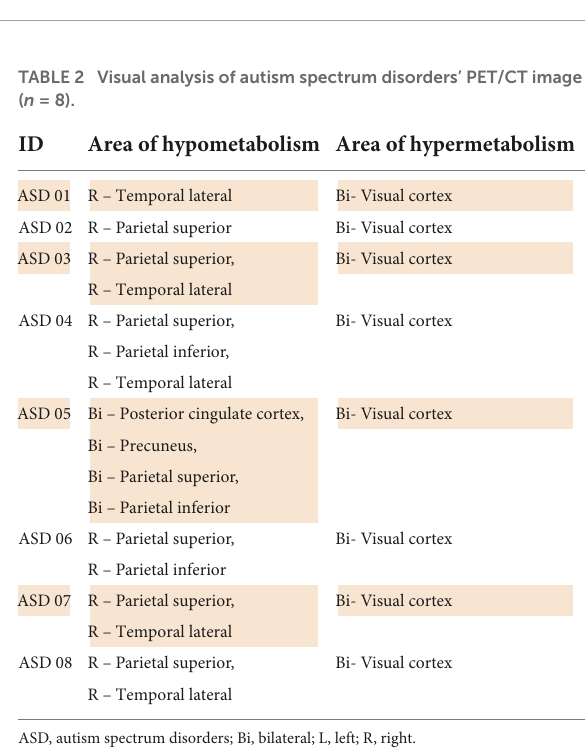
TABLE 2 Visual analysis of autism spectrum disorders’ PET/CT image ( n =